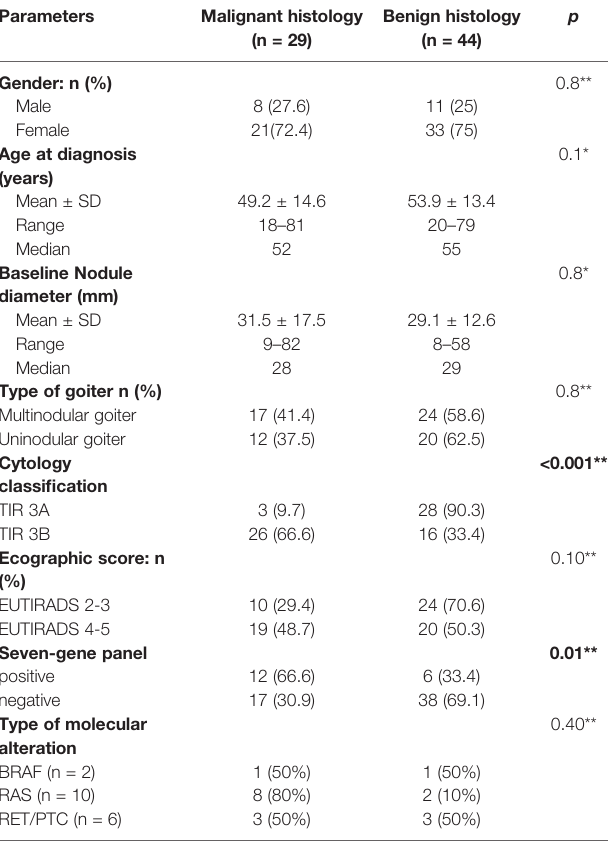
TABLE 2 | Demographic and clinical-pathological features in patients with indeterminate thyroid nodules submitted to surgery (n = 73). Parameters Malignant histology Benign histology (n = 29) (n =